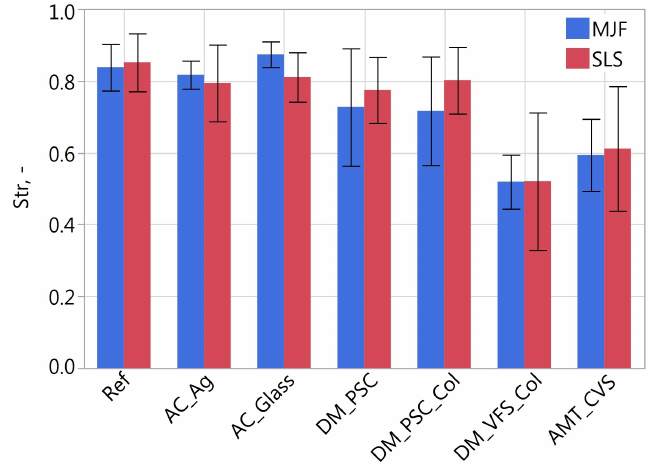
Figure 15. Texture aspect ratio Str of measured samples.